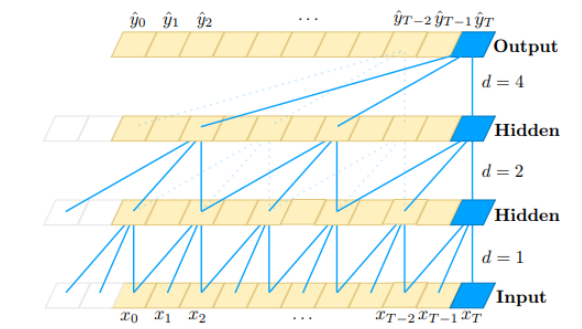
Figure 6. Example of TCN architecture with